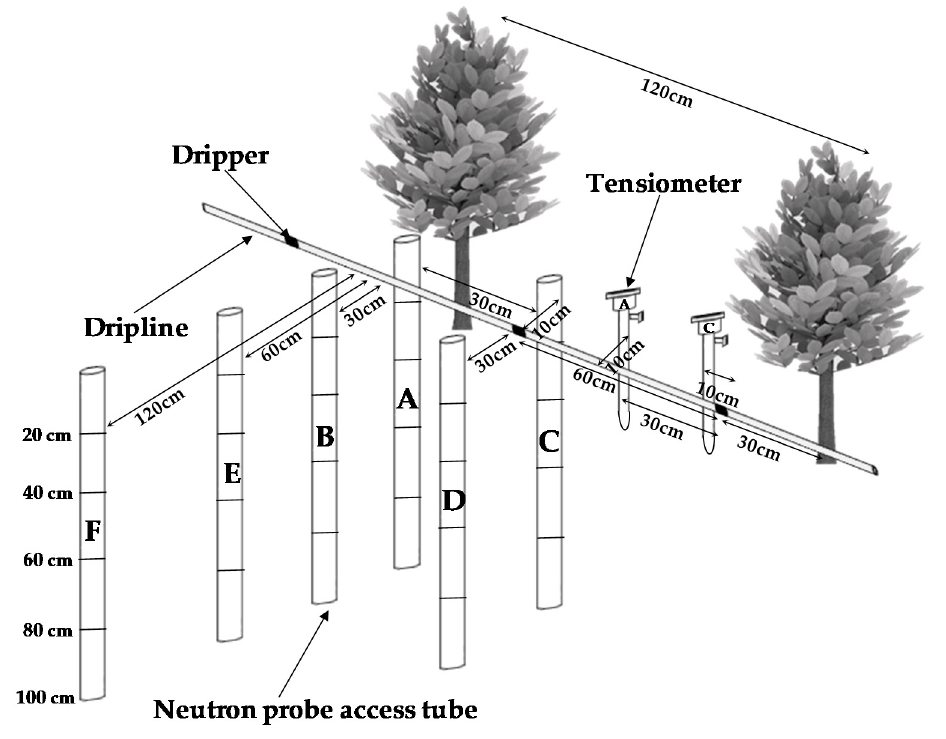
Figure 2. Relative positions and depths of the neutron probe access tubes and tensiometers.